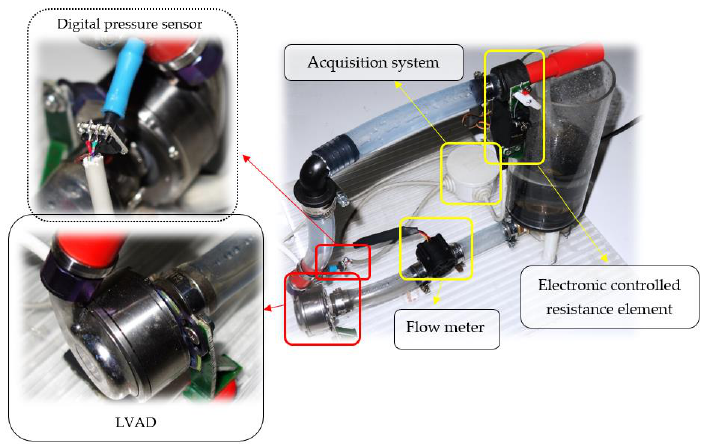
Figure 2. Mock circulatory loop used to characterize LVAD power requirements.